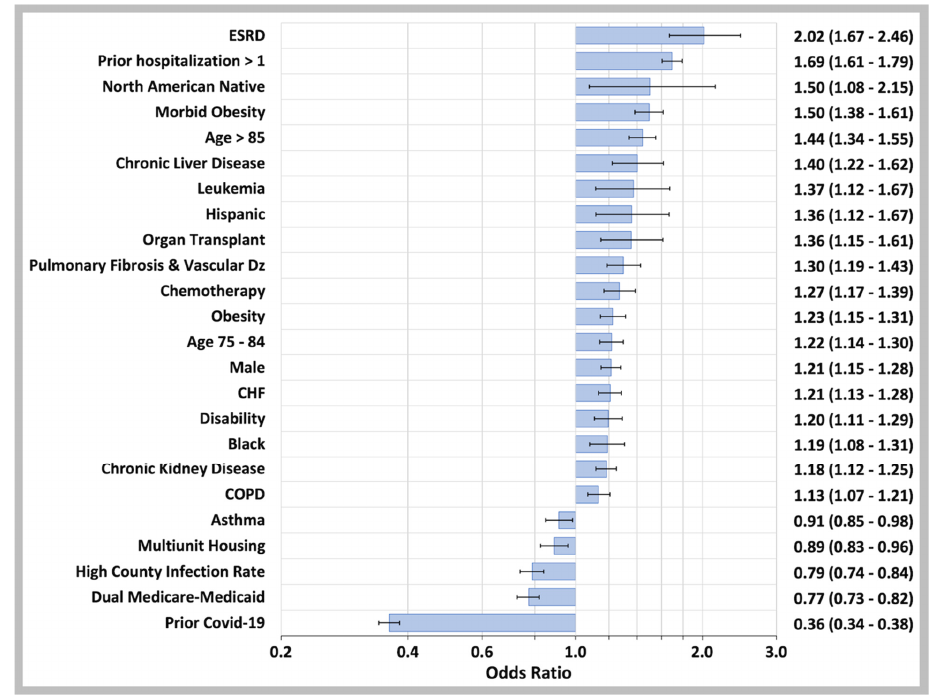
Figure 6. Predictor Variables for COVID-19 Breakthrough Case Hospitalization. Odds ratios determined by binary logistic regression analysis of confirmed COVID-19 breakthrough cases that re- quired hospitalization for the disease and those that were managed with outpatient care only. The independent variables are on the left of the plot while the odds ratios values with 95% CI are on the right. Not shown: anticoagulant drugs (OR 1.20, 95% CI 1.12–1.29), opioid drugs (OR 1.20, 95% CI 1.11–1.30), antiplatelet drugs (OR 1.17, 95% CI 1.07–1.28), NSAID drugs (OR 1.14, 95% CI 1.03–1.27), Beta-2 agonist drugs (OR 1.12, 95% CI 1.02–1.23), ACE inhibitor drugs (OR 1.09, 95% CI 1.03–1.16), immunosuppressive drugs (OR 0.89, 95% CI 0.79–0.99), Azithromycin drugs (OR 0.88, 95% CI 0.77– 1.00), or other ethnicities (OR 0.76, 95% CI 0.61–0.97). Multiunit housing variable: CDC SVI_EPL_MUNIT top quartile; High County Infection rate: beneficiary county of residence in the